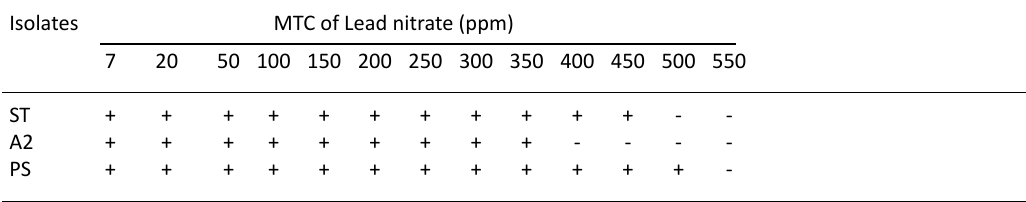
Table 3. Maximum Tolerable Concentration of Cadmium Chloride (ppm): Isolates MTC of Lead nitrate